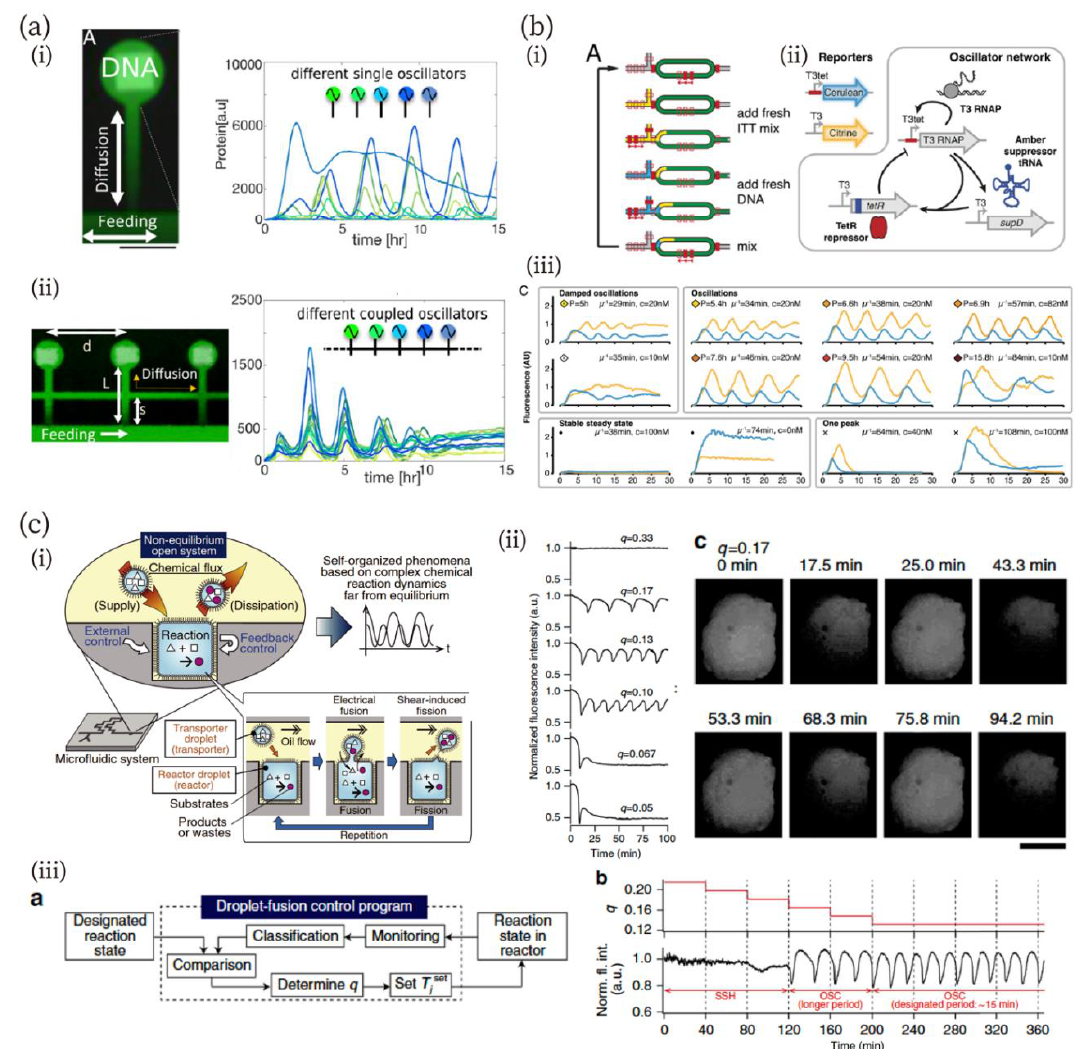
Figure 5. ( a ) On-chip DNA compartments as artificial cells [106]. (i) An image of expressed green fluorescence protein (GFP) (green) and DNA patterns (white), and a graph of oscillation dynamics in 15 different compartments. Scale bar: 100 µm. (ii) An image of three coupled compartments and a graph of the synchronized oscillations in the coupled compartments. Reproduced with permission from [106]. ( b ) In vitro transcription/translation system in a microfluidic nanoreactor [113]. (i) and (ii) Schematics of the nanoreactor (i) and an oscillator network (ii). (iii) Oscillation behavior of the network in the nanoreactor controlled by microfluidic parameters. Reproduced with permission from